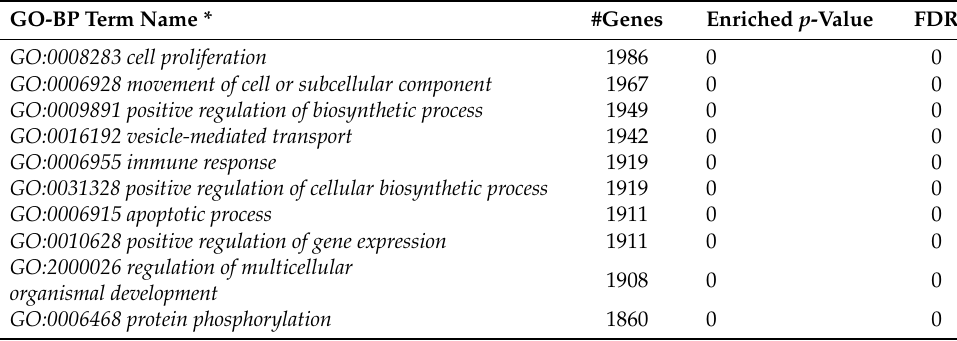
Table 6. Top significant GO-BP term enriched (FDR sorted).